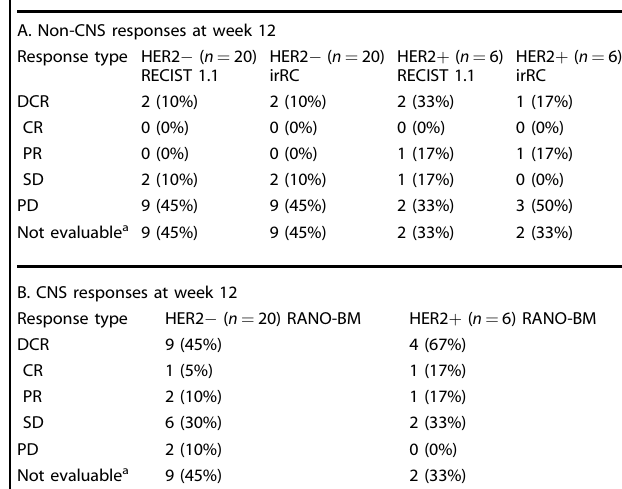
Table 2. Treatment-related toxicities and adverse events. Table 3. Responses at week